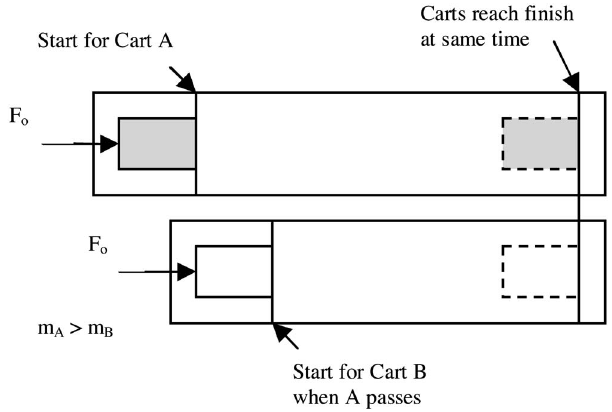
FIG. 2. Diagram (cid:1) top view (cid:2) used in all recitations for the second post-test